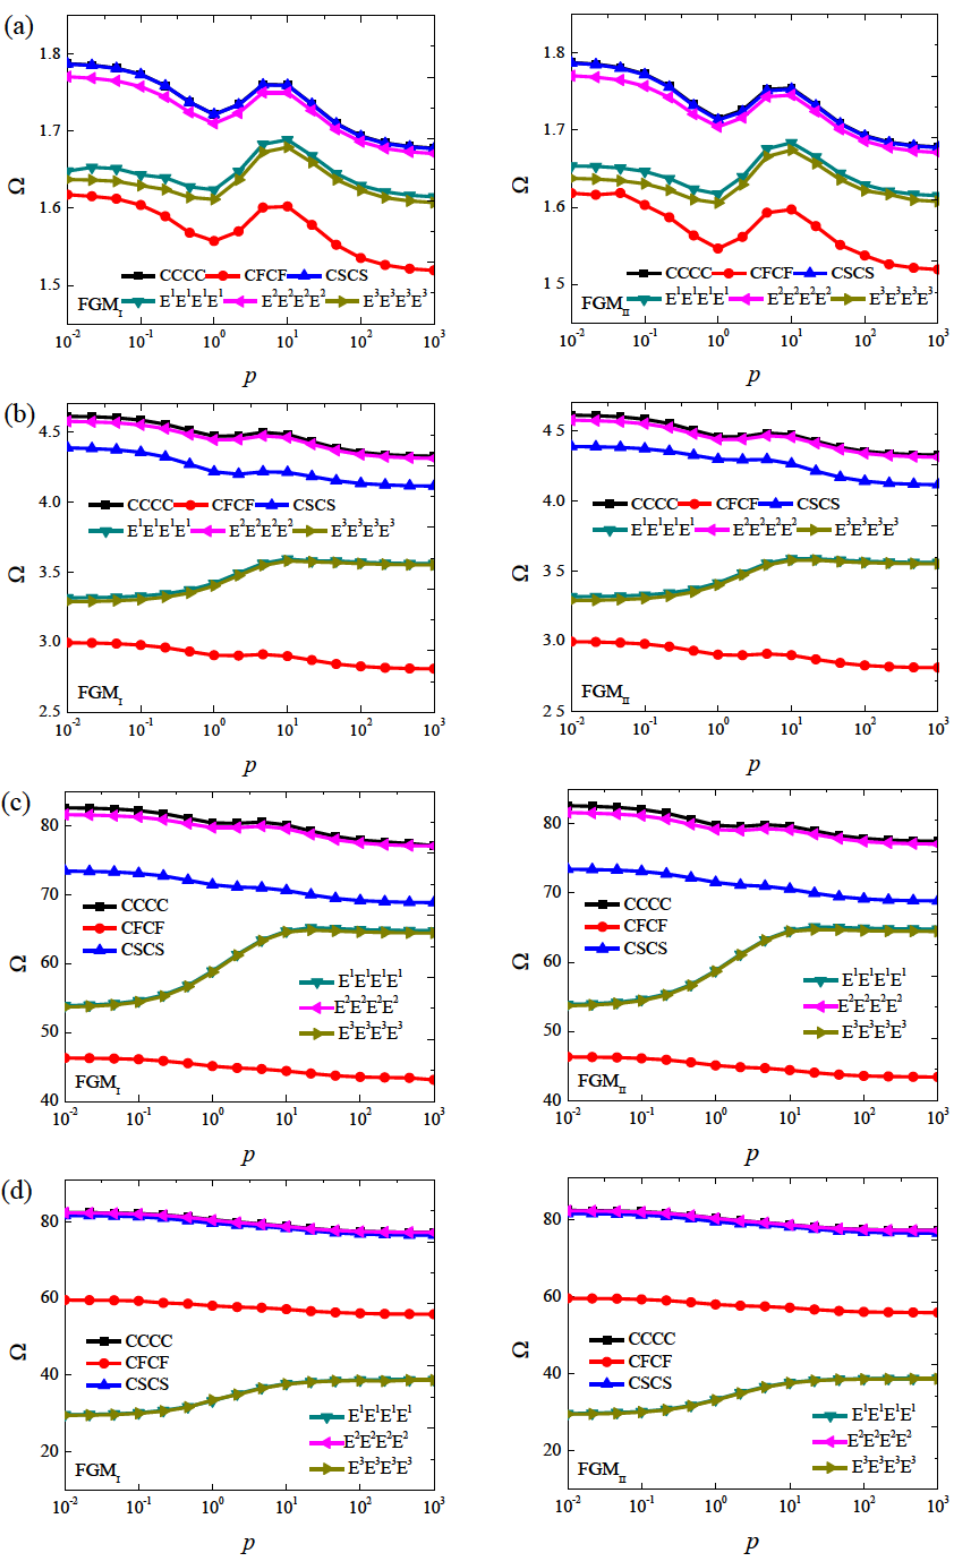
Figure 12: Variation of the fundamental frequencies of FGM panels with different power-law exponent p and boundary conditions: (a) Toro- parabolic panel; (b) Parabolic panel; (c) Toro-circular panel; (d) Spherical